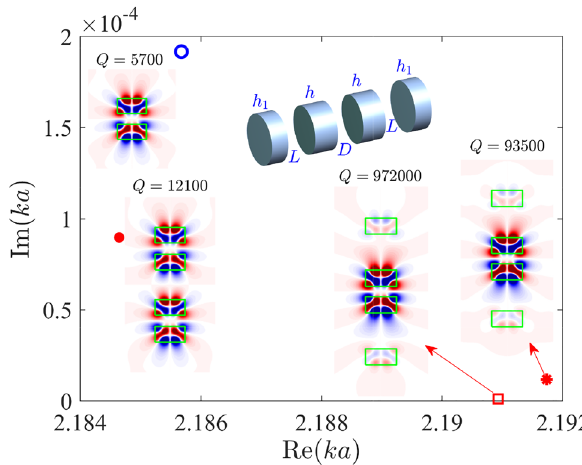
Figure 5: The same as in Figure 4 but the resonant mode of the inner dimer is tuned to the Mie-like mode with l = 6 at h = 1 . 038 , D = 0 . 734 [ 25 ]. The left bottom panel shows the SP quasi-BIC = 1 . 038 , L = 0 . 752 , D = 1 . 985 consisted of two dimers h = h 1 (closed circle), the central and the right panels show the dimer sheltered by disks with scales respectively h = 1 . 03895 , h 1 = 1 . 01727 , L = 2 . 2711 , D = 0 . 6585 (square) and h = h = 1 . 038 , 1 L = 2 . 02 , D = 0 . 661 (star).